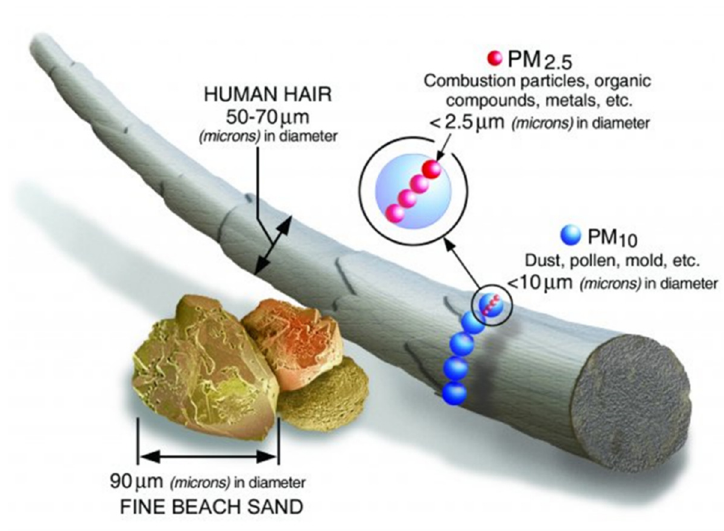
Figure 1. Comparisons of particulate matter size (PM) [44].